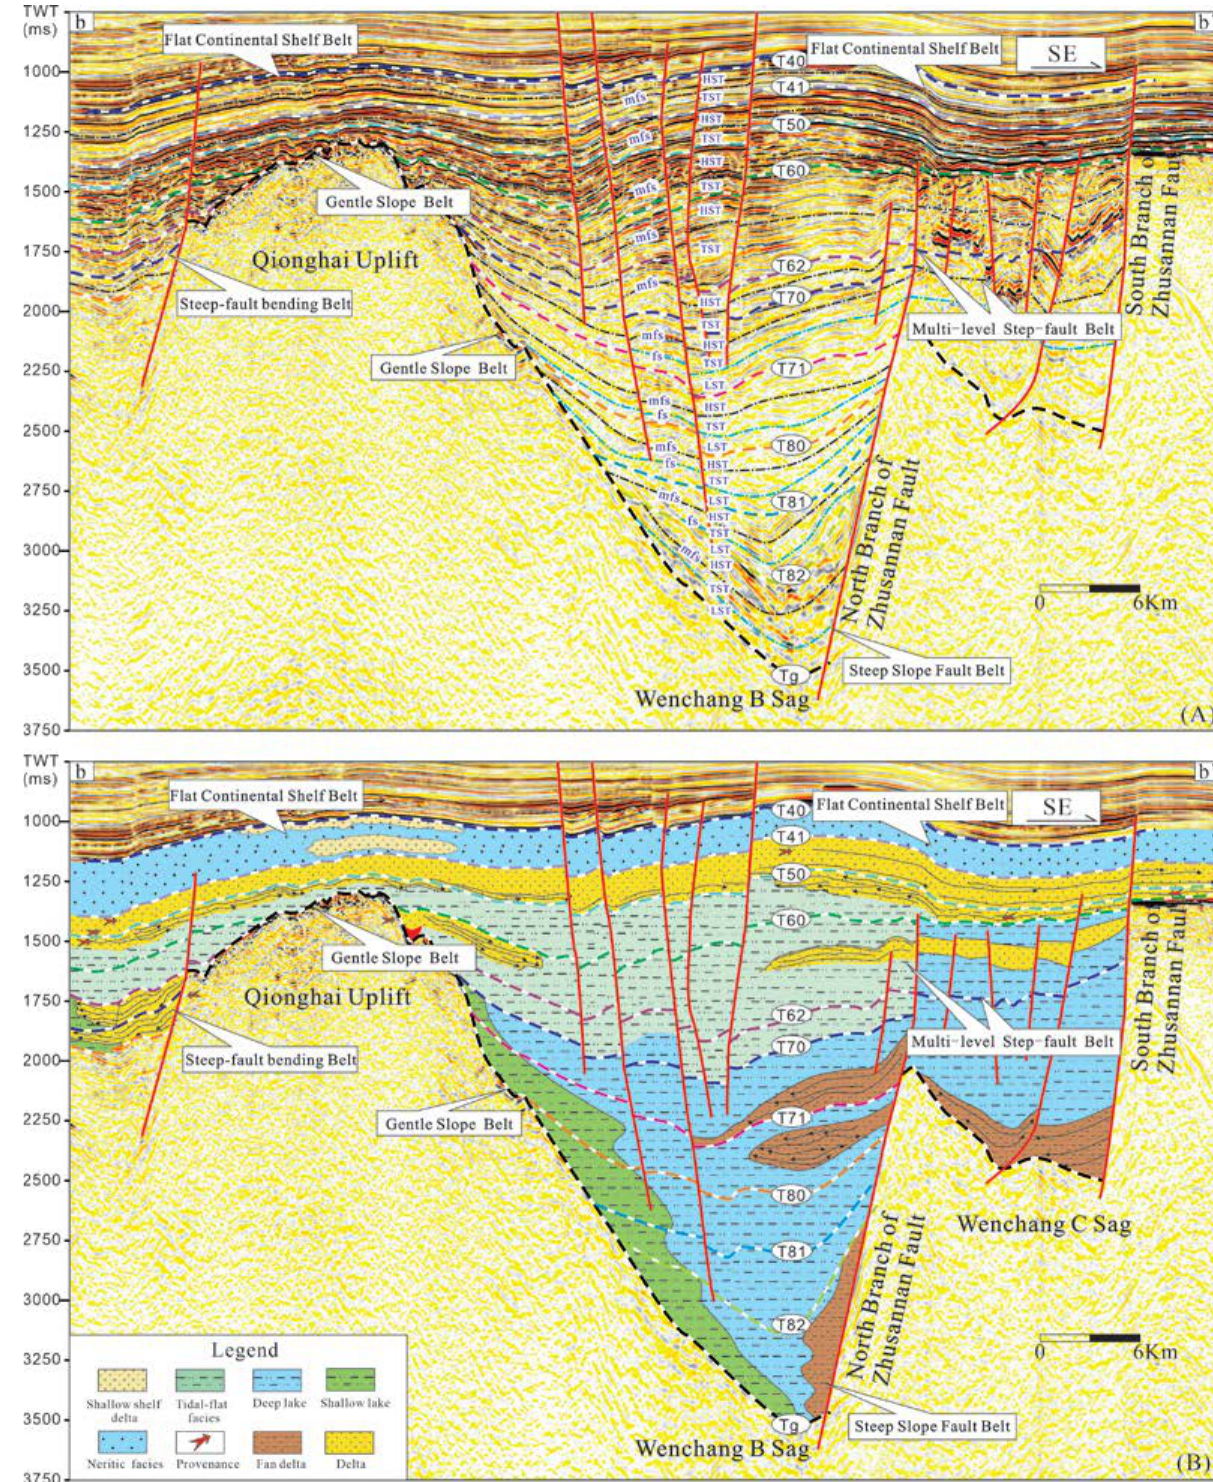
Figure 7. ( A ) interpreted seismic section bb’ showing seismic reflection characteristics and the distribution regions of different stratal stacking patterns; ( B ) the types of depositional facies and their distribution ranges in the section bb’ showing the depositional evolution from the Eocene to the Miocene. The location of section bb’ is shown in Figure 1.